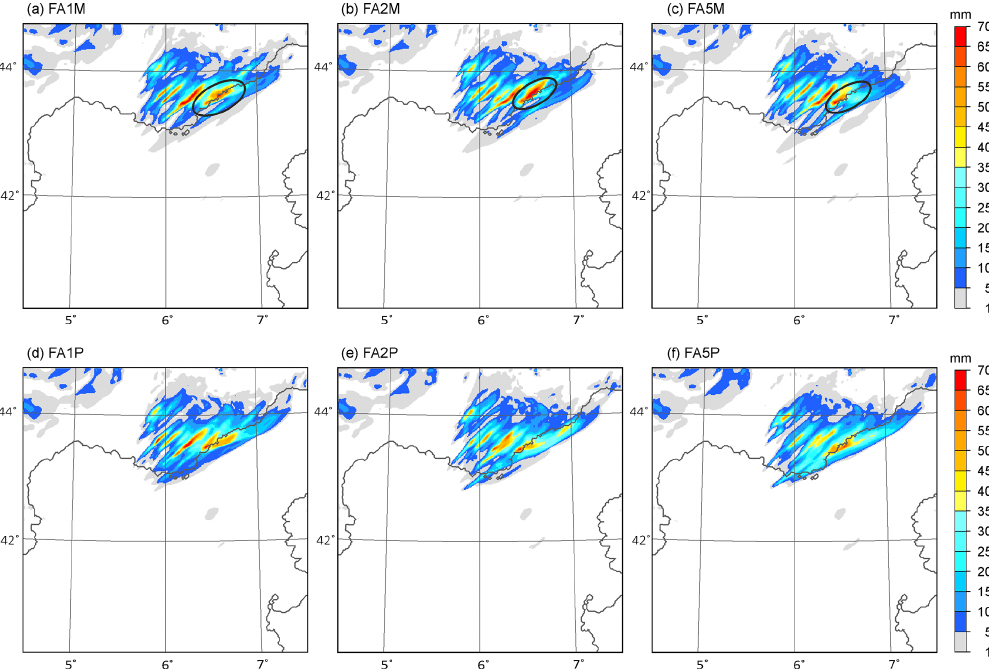
Figure 13. Same as Fig. 7 for (a) FA1M, (b) FA2M, (c) FA5M, (d) FA1P, (e) FA2P, and (f) FA5P. In panels (a) – (c) , the reduced precipitation around the coast is indicated by a closed ellipsoid with a solid line.